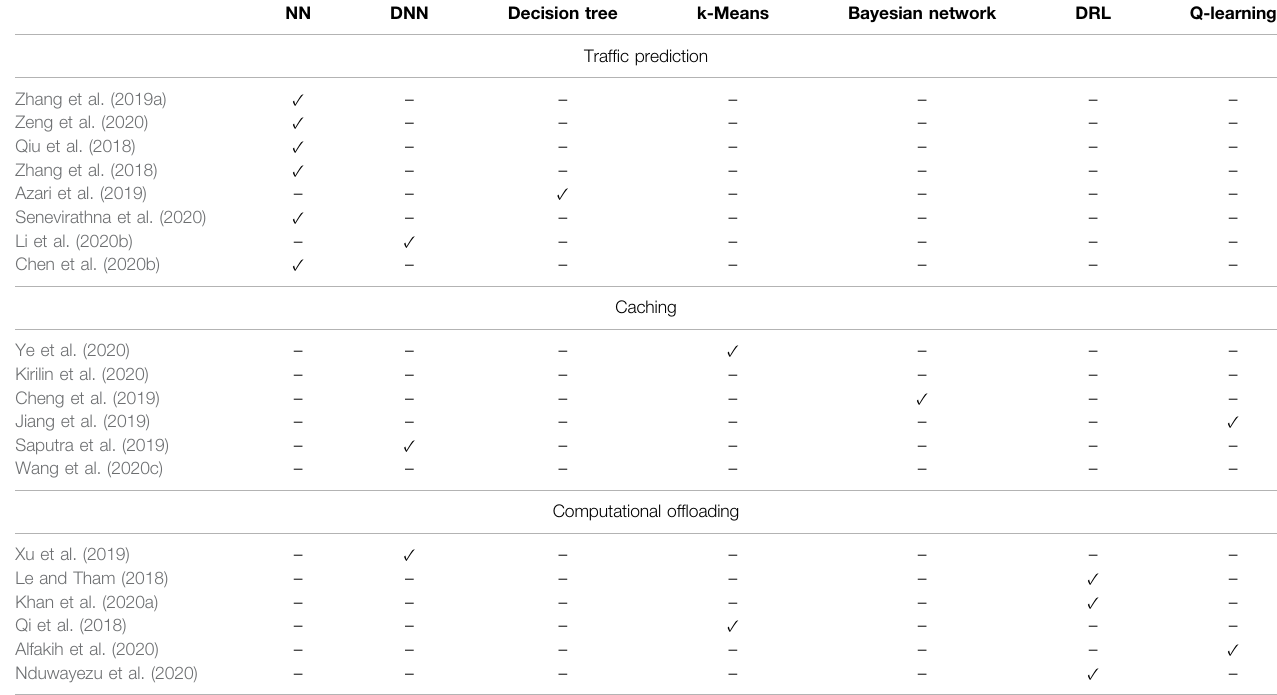
TABLE 5 | ML algorithm types applied in transport